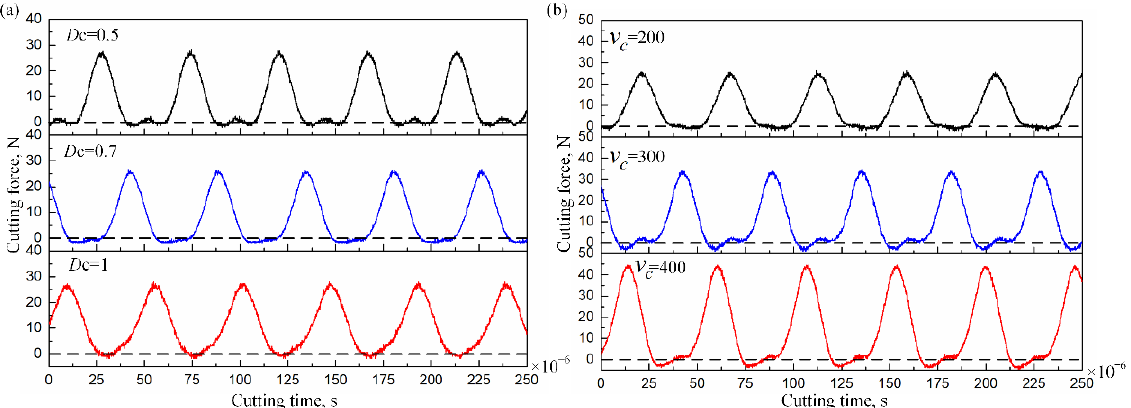
Figure 14. Transient cutting force signal for HUVC Ti alloys. ( a ) cutting speed is 200 m/min, ( b ) duty cycle is 0.6. Cooling pressure, feed per revolution, and cutting depth are 20 MPa, 0.005 mm/r, and 0.05 mm, respectively. Dc , duty cycle, v c , cutting